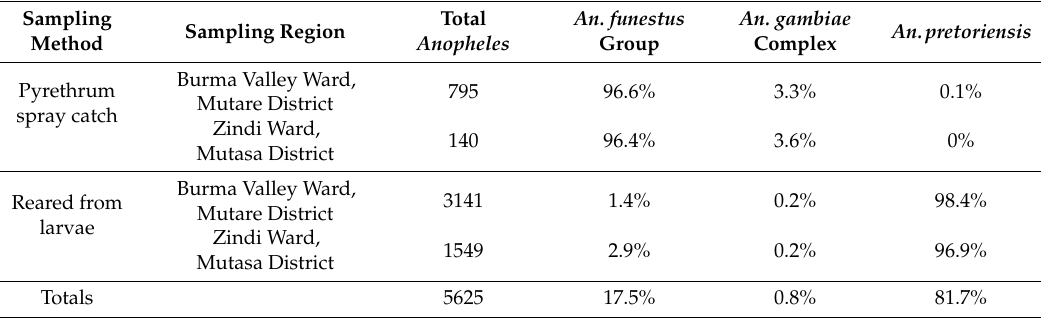
Table 9. Species composition (%) and abundance of anophelines captured by sampling method and locality in eastern Zimbabwe